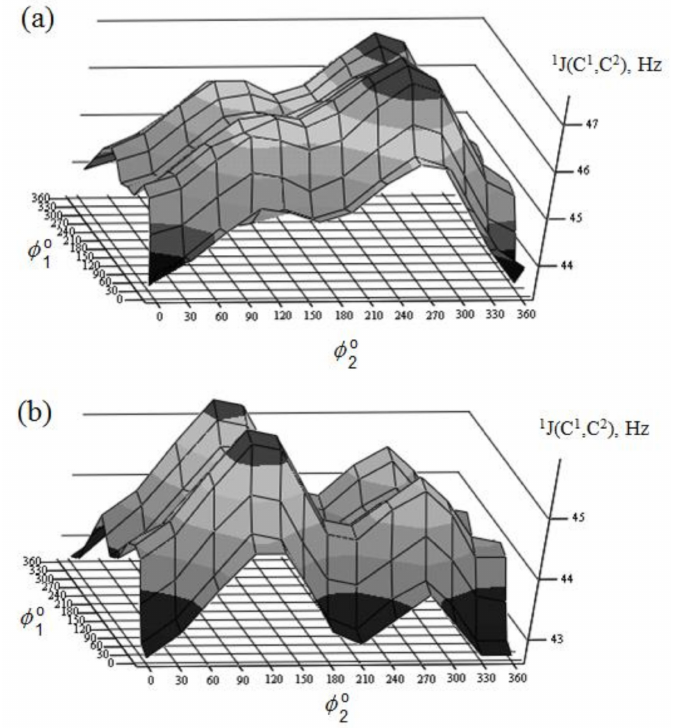
Figure 30. Rotational surface of 1 J (C-1,C-2) of ( a )— α -D-mannopyranose and ( b )— β -D-mannopyranose. Reproduced from the PhD Thesis by Danilova